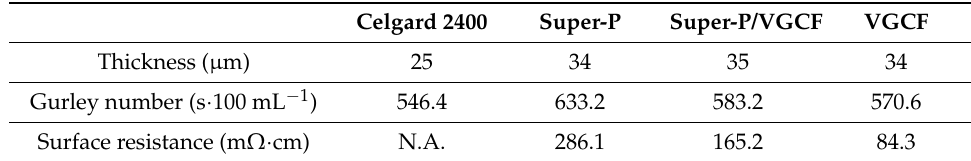
Figure 1. Scanning electron microscopy (SEM) images of the separator surface containing ( a ) Super-P; ( b ) Super-P/vapor-grown carbon fiber (VGCF) (5:5 by wt.%); and ( c ) VGCF. Table 1. Physical properties of bare polypropylene (PP) and different conductive additives (Super-P, Super-P/VGCF, VGCF).